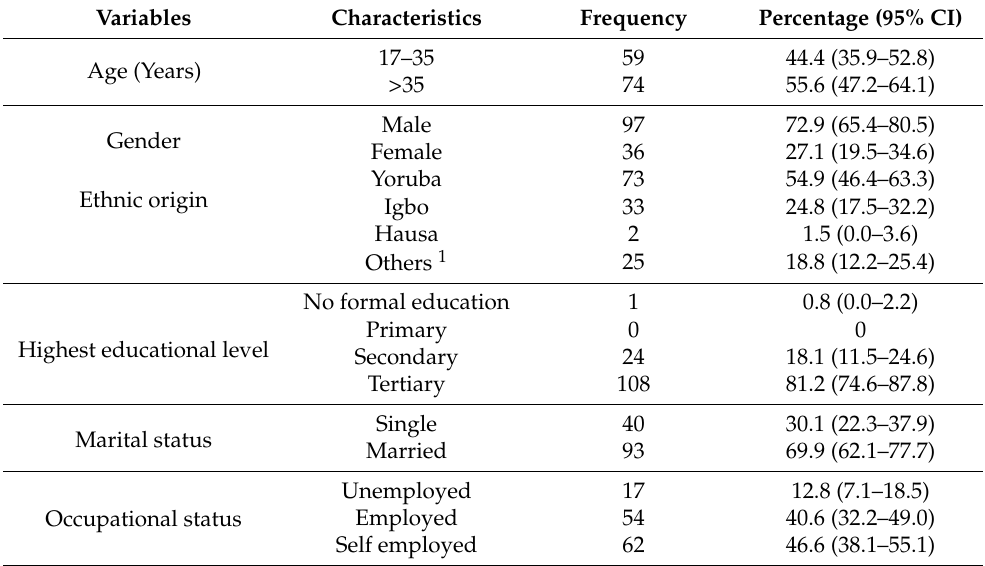
Table 1. Socio-demographic characteristics of the dogs owners ( n = 133) presented at veterinary clinics or hospitals in Lagos State, Southwest Nigeria, in 2018–2019.